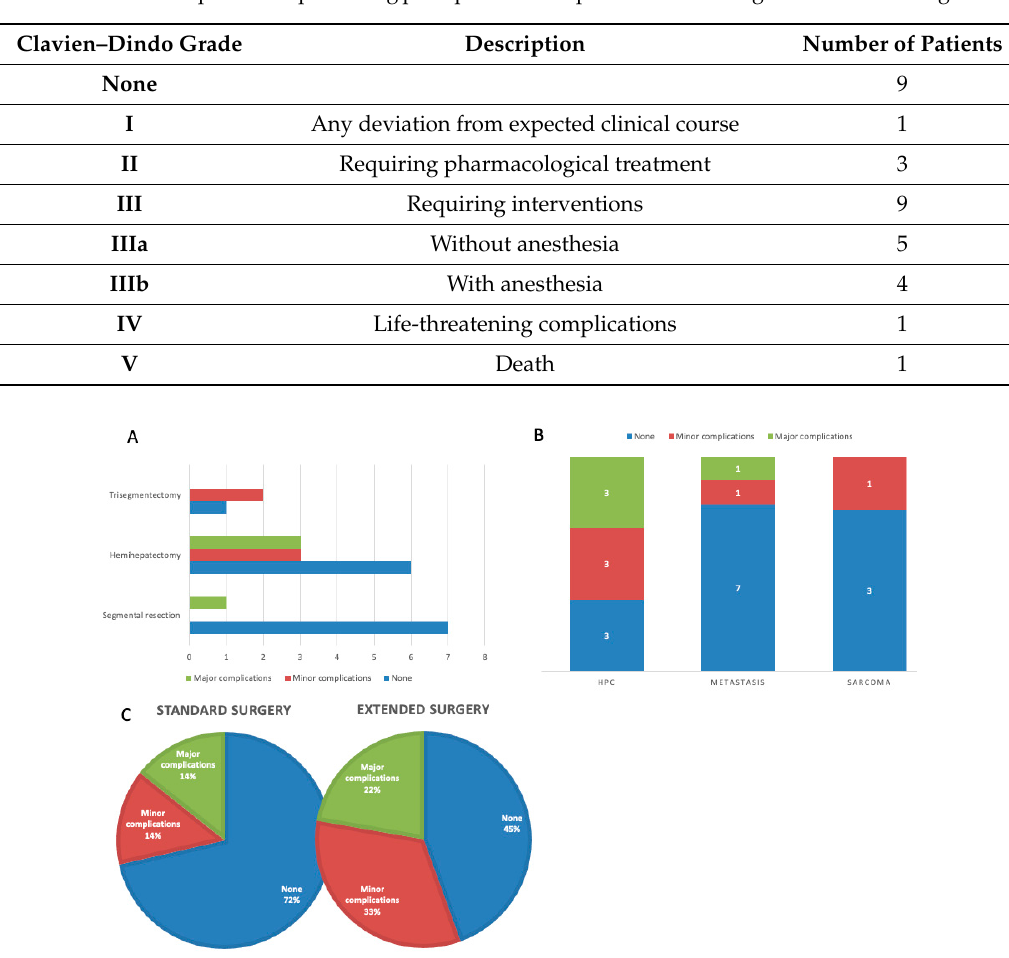
Figure 2. Occurrence of postoperative complications in relation to surgically relevant parameters